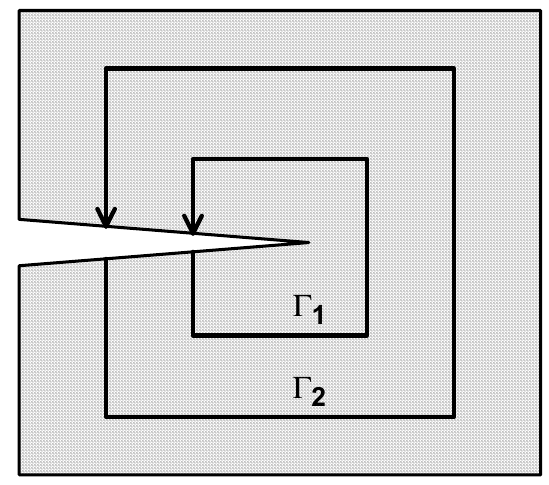
Figure A2. Definition of the contour Γ . Table A1. Comparison of numerical and analytical values of Rice’s integral RJ.